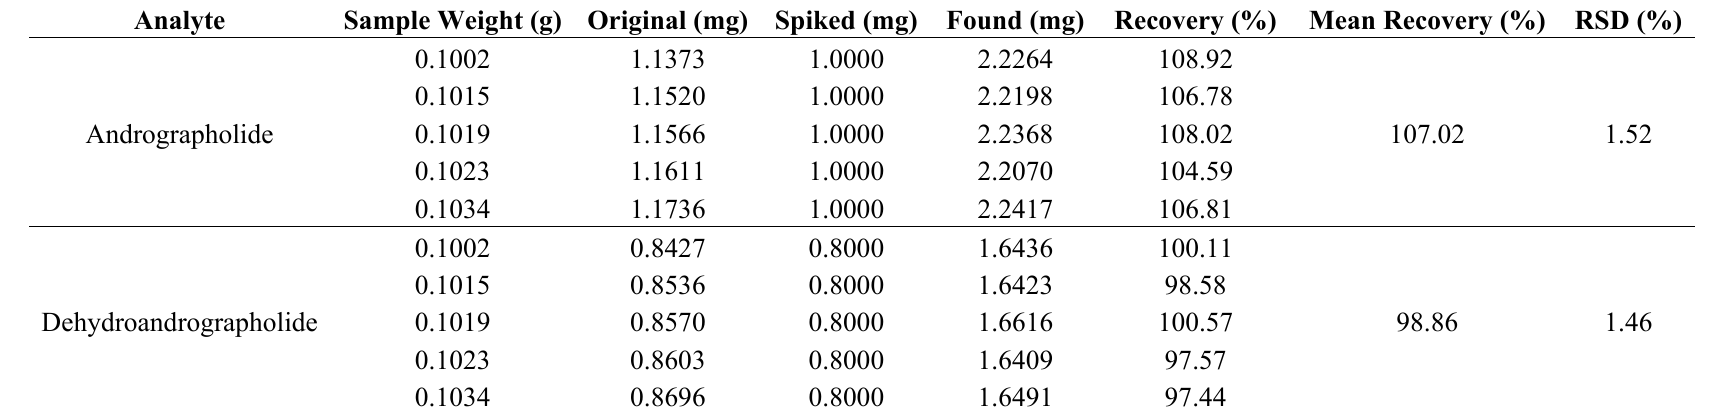
Table 3. Accuracy of HPLC - UV method for determination of andrographolide and